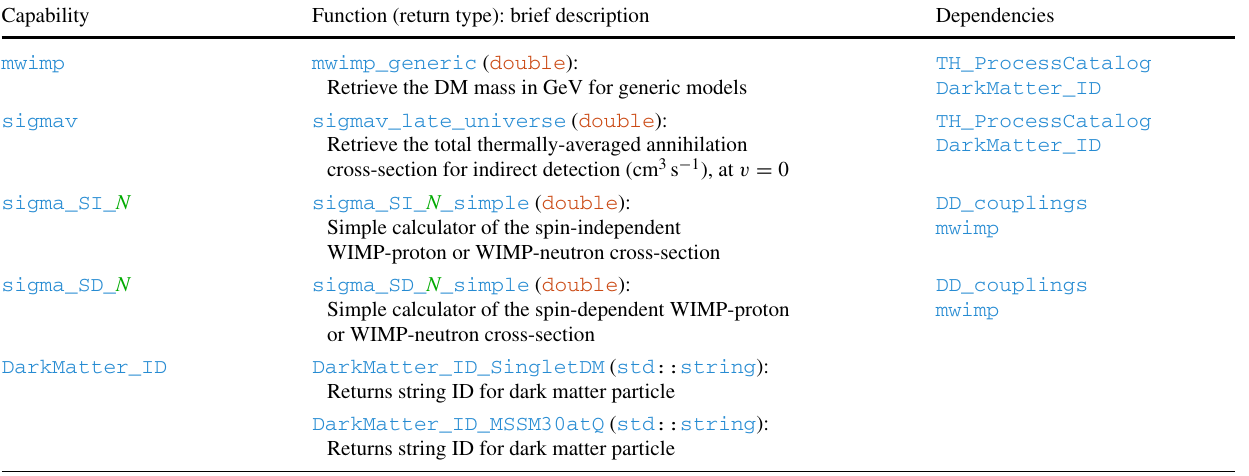
Table 14 DarkBit capabilities for WIMP-nucleon couplings ( N = p , n refers to the relevant nucleon), annihilation cross-section, dark matter mass and dark matter particle ID.